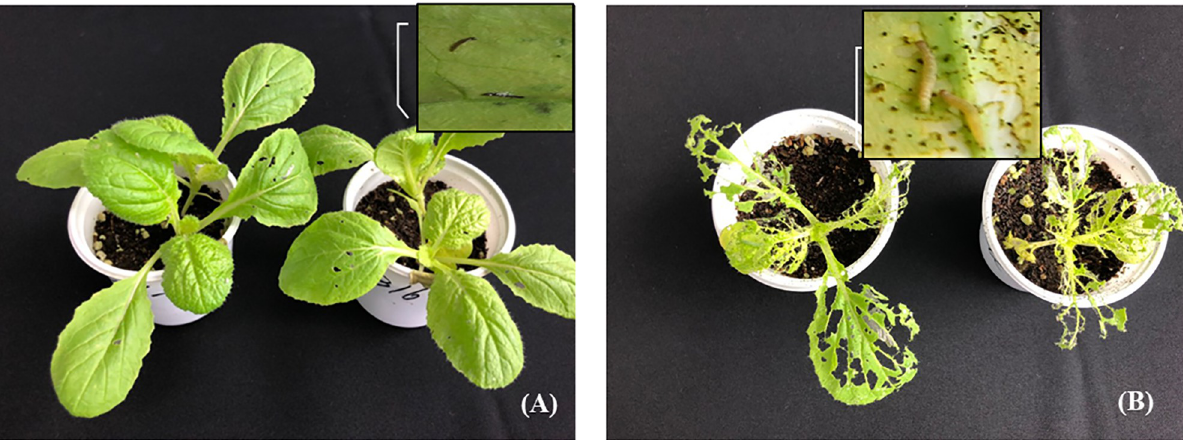
Fig 3. Insecticidal activities of the broth filtrate of KR0006 against Plutella xylostella 2 nd instars in greenhouse conditions. Representative pictures were taken five days after inoculation. (A); 2-fold dilution of broth filtrate, (B); untreated control.